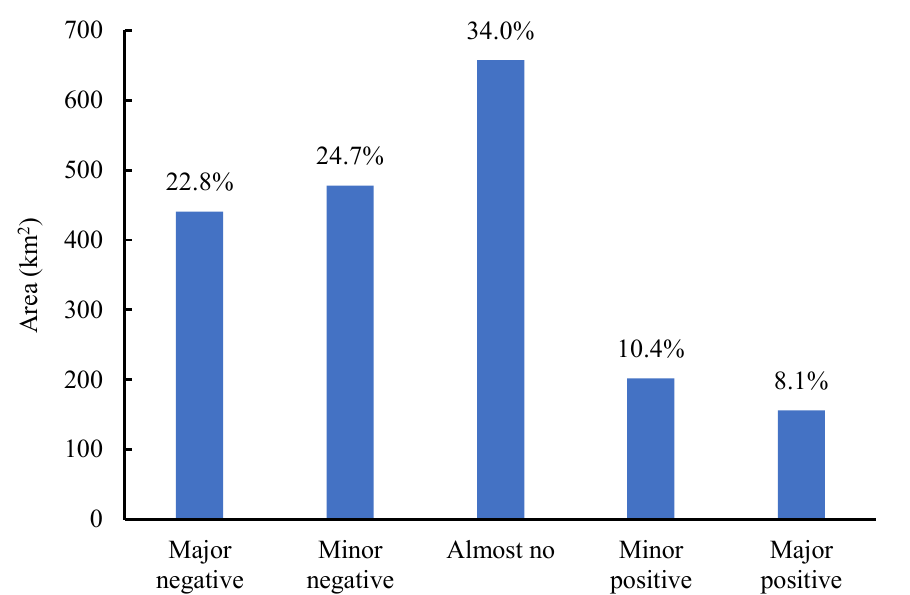
Figure 5. Area of each class of the neighboring effects by patches in Xintai City.